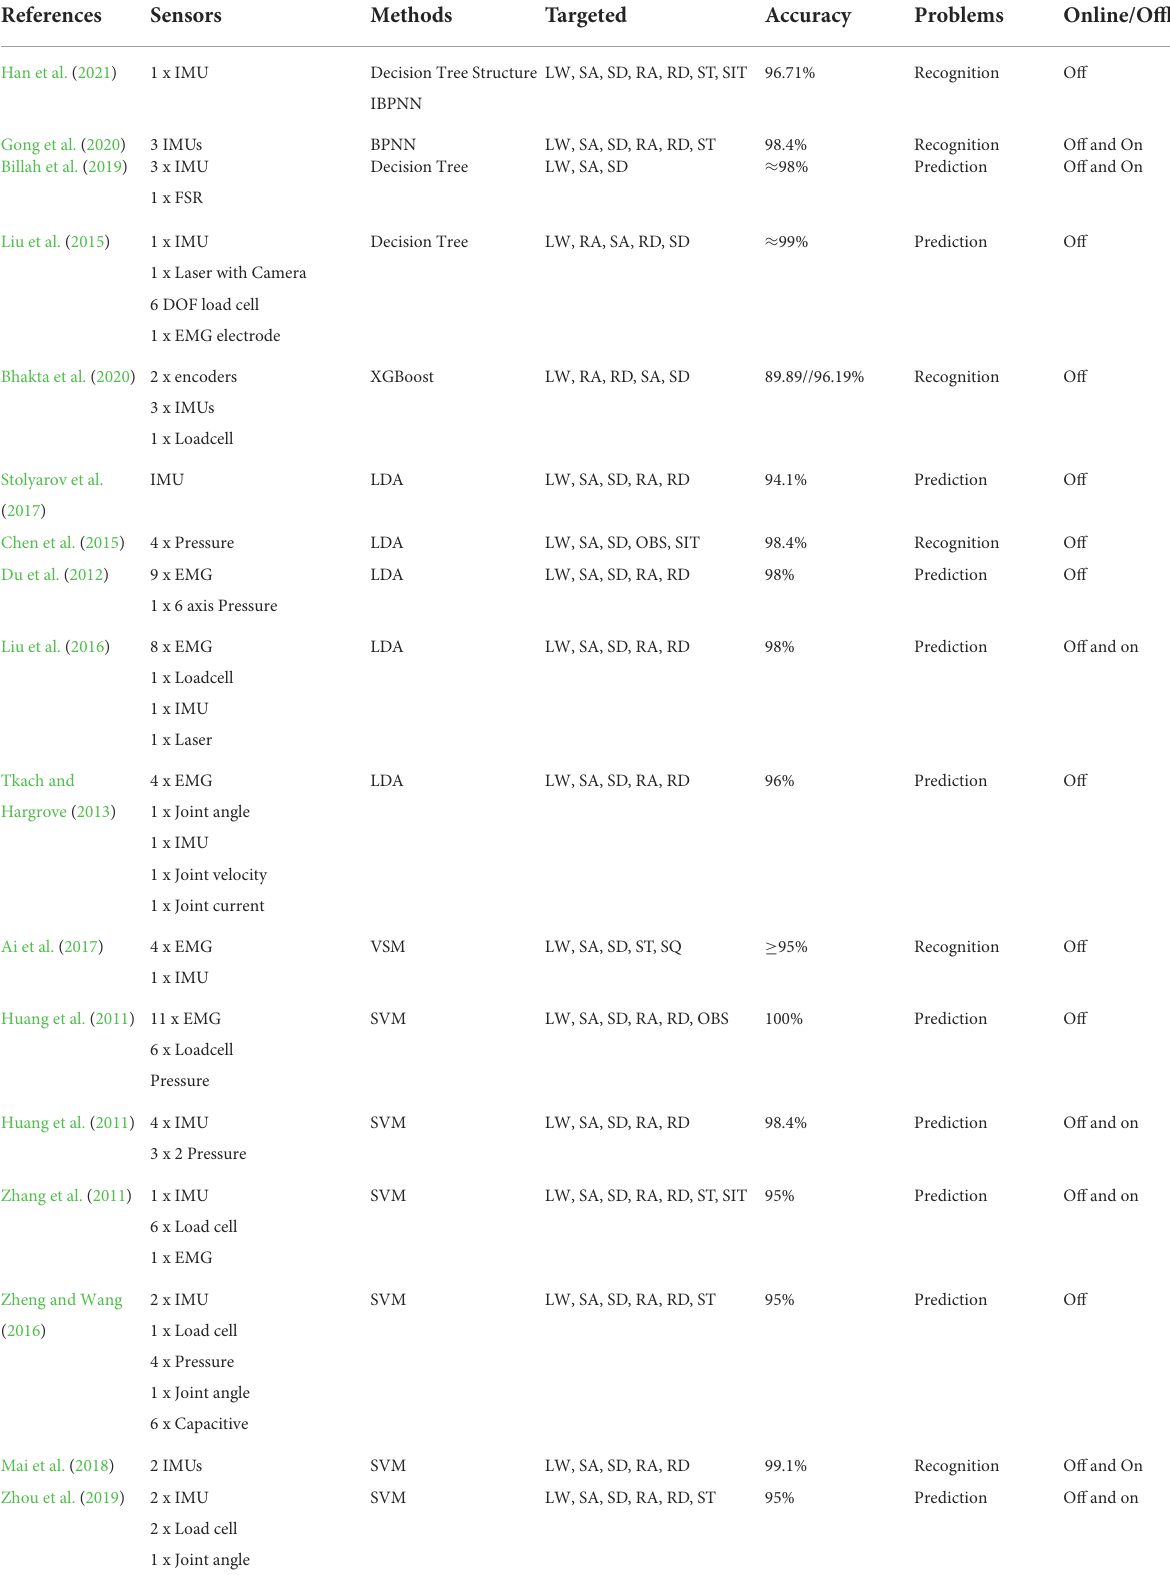
TABLE 5 Existing locomotion recognition based on machine learning methods using signals from many sensor